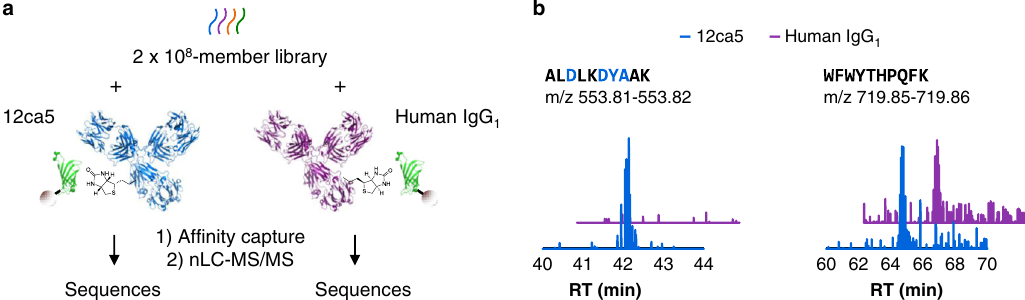
Fig. 3 Parallel selections enable differentiation of speci fi c and non-speci fi c binders. a Using AS-MS, the same population of compounds can be used in selections against more than one target in parallel, enabling assessment of target-dependent enrichment of peptides. Here, selections using a 2 × 10 8 - member library were performed against 12ca5 and a polyclonal human IgG 1 in parallel, followed by sequential nLC-MS/MS analysis. b Extracted ion chromatograms of a DXXDY(A/S)-containing peptide (left) and a non-motif-containing peptide (right) from a selection against 12ca5 (blue) and polyclonal human IgG 1 (purple). The peptide containing the 12ca5-binding motif is selectively enriched towards 12ca5, while the non-motif-containing peptide is promiscuously pulled down in both